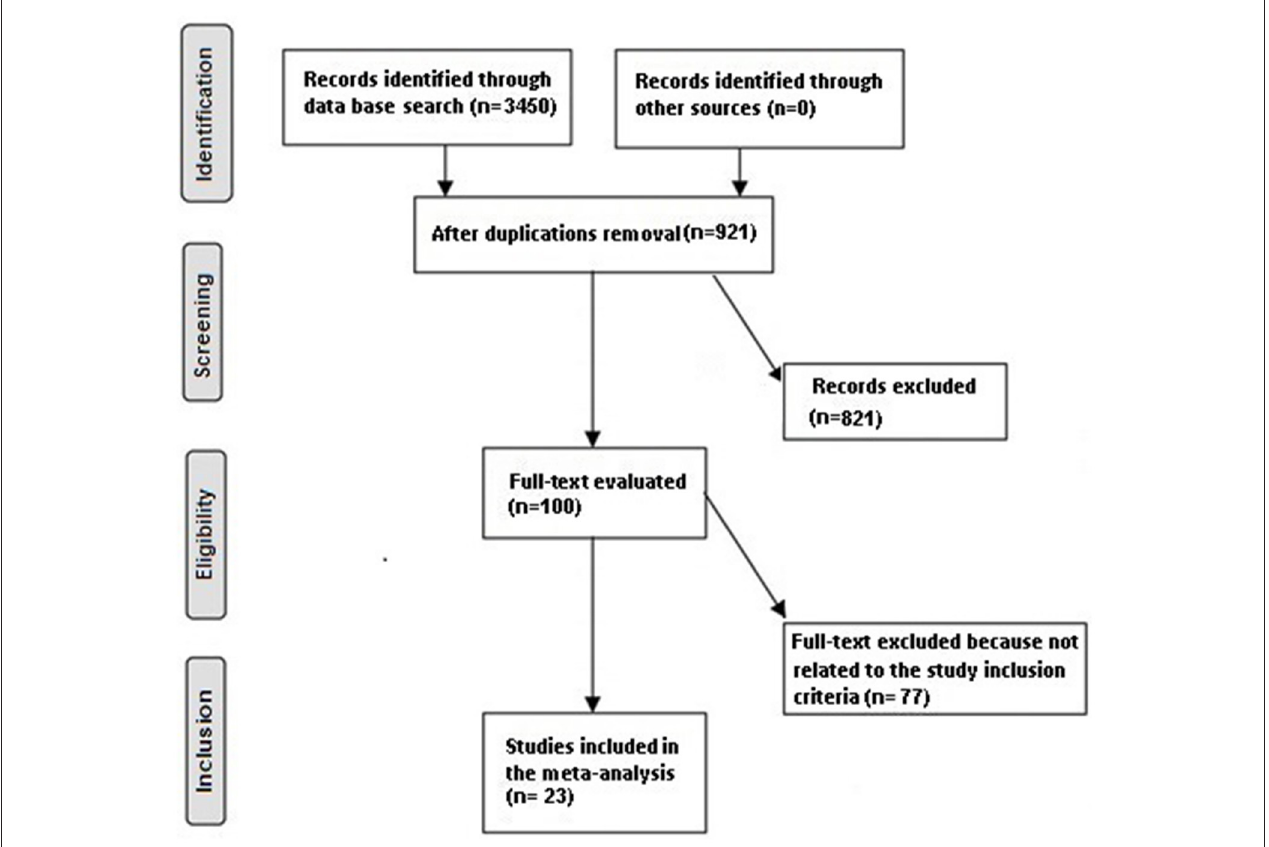
FIGURE 1 | Schematic illustration of the study